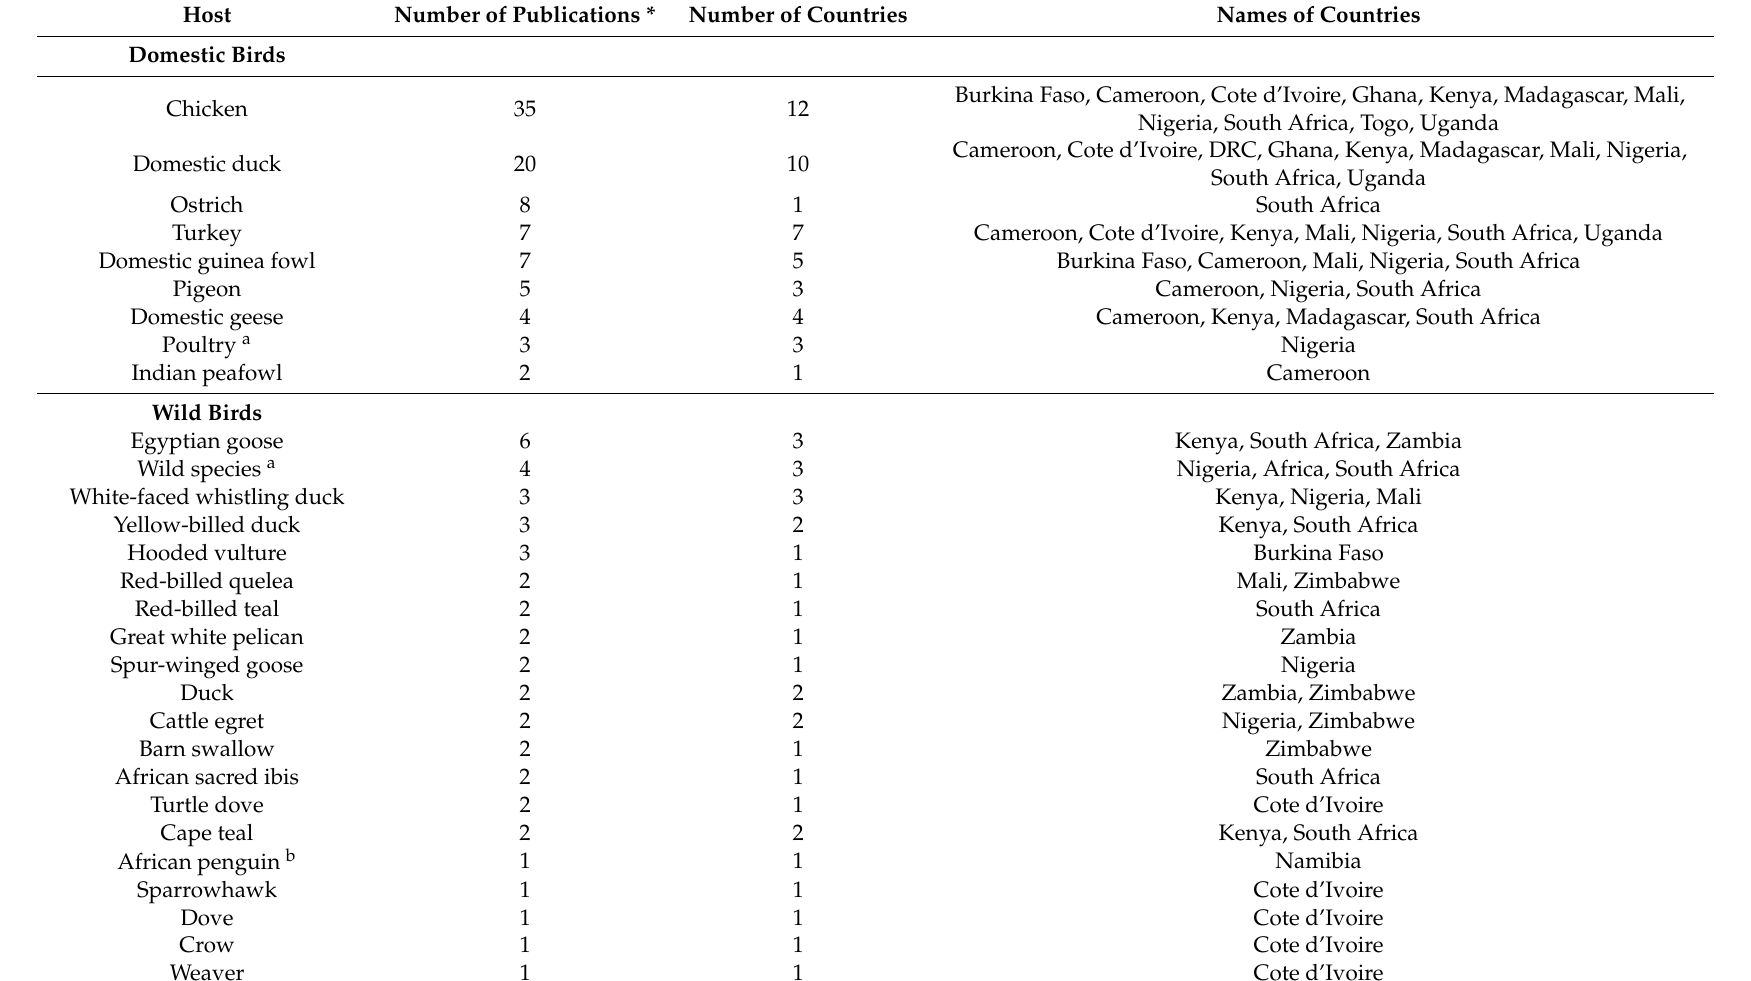
Table 5. Avian host range of AIV according to the 68 publications included in the